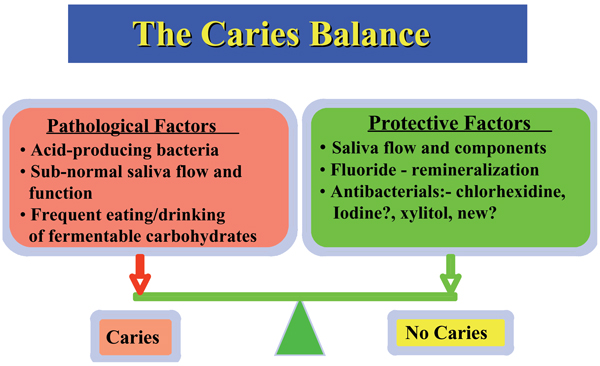
Schematic diagram of the "Caries Balance" (adapted from Featherstone, 2003)[2].